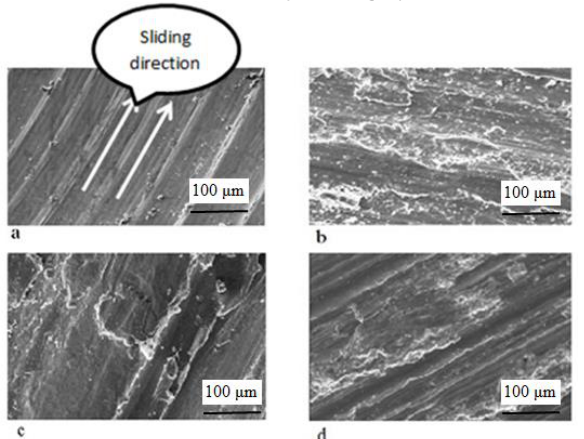
Fig. 5. Microstructures of worn surfaces of (a) pure Al6061-T6, b) Al6061-T6 + 5 wt percent titanium carbide, c) Al6061-T6 + 5 wt percent graphite d) Al6061-T6 + 5 wt percent titanium carbide + 5 wt percent